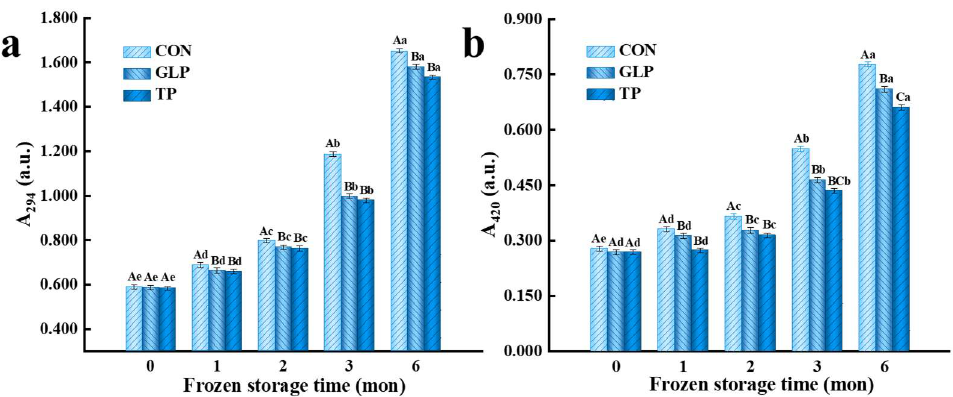
Figure 2. Effect of guava leaf polyphenols on the Maillard reaction of frozen chicken meatballs. ( a ), A 294 ; ( b ), A 420 . GLP, guava leaf polyphenols; TP, tea polyphenol; CON, control. The means at the same frozen storage with different uppercase letters (A–C) differ significantly ( p < 0.05); the means at the same polyphenol processing with different lowercase letters (a–e) differ significantly ( p < 0.05). The results are mean ± SE ( n = 3).